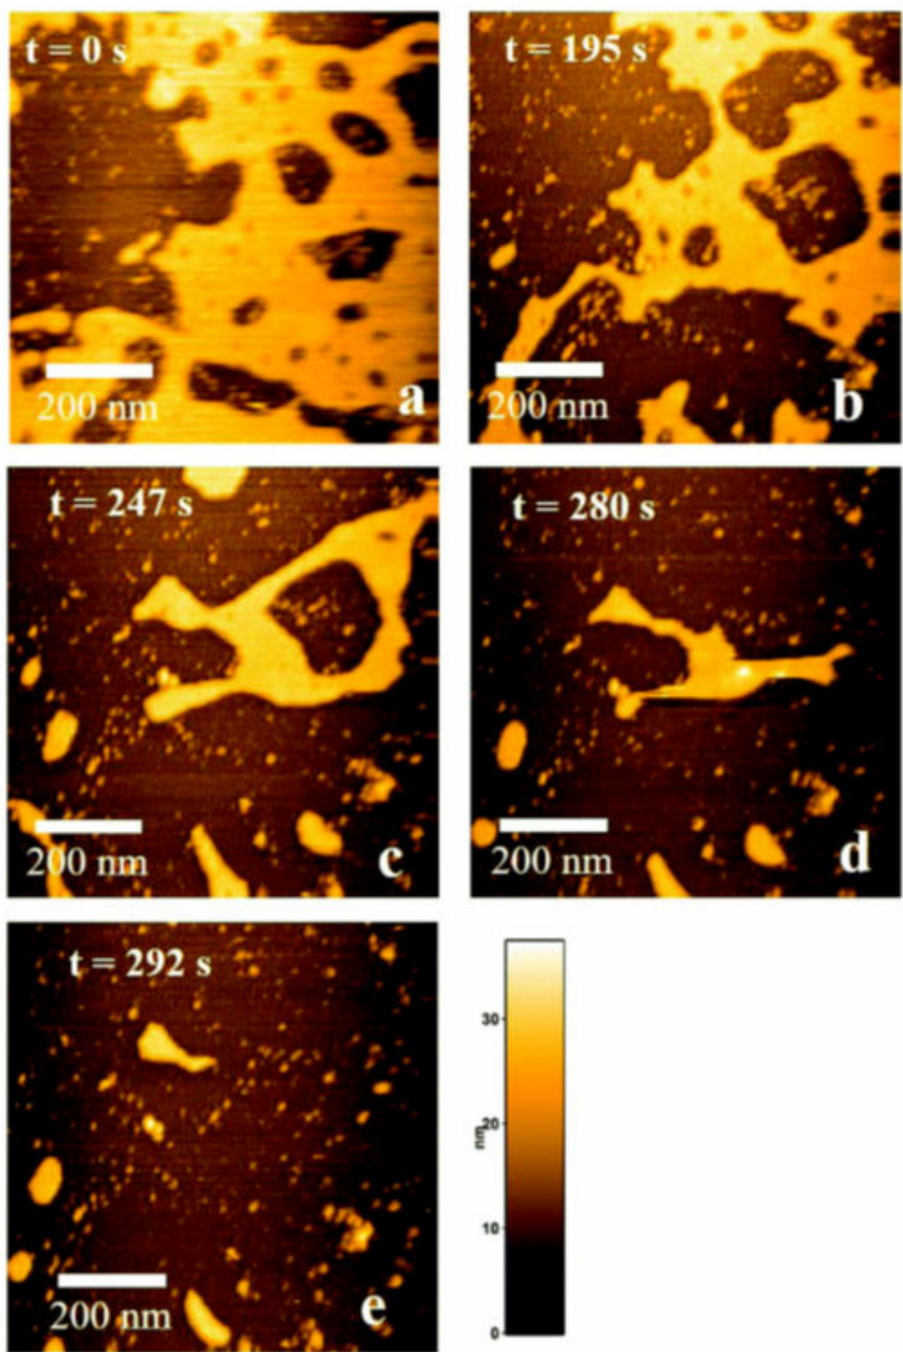
Figure 10. HS-AFM images of sphingomyelin (SM) / 1-palmitoyl-2-oleoylphosphatidylcholine (POPC) / cholesterol (Chol) / GM1-ganglioside (GM1) membrane disruption after the addition of A β 42 oG37C oligomers ( a – e ). The membrane with holes was removed from its edge. Reproduced from [111] with permission from The Royal Society of